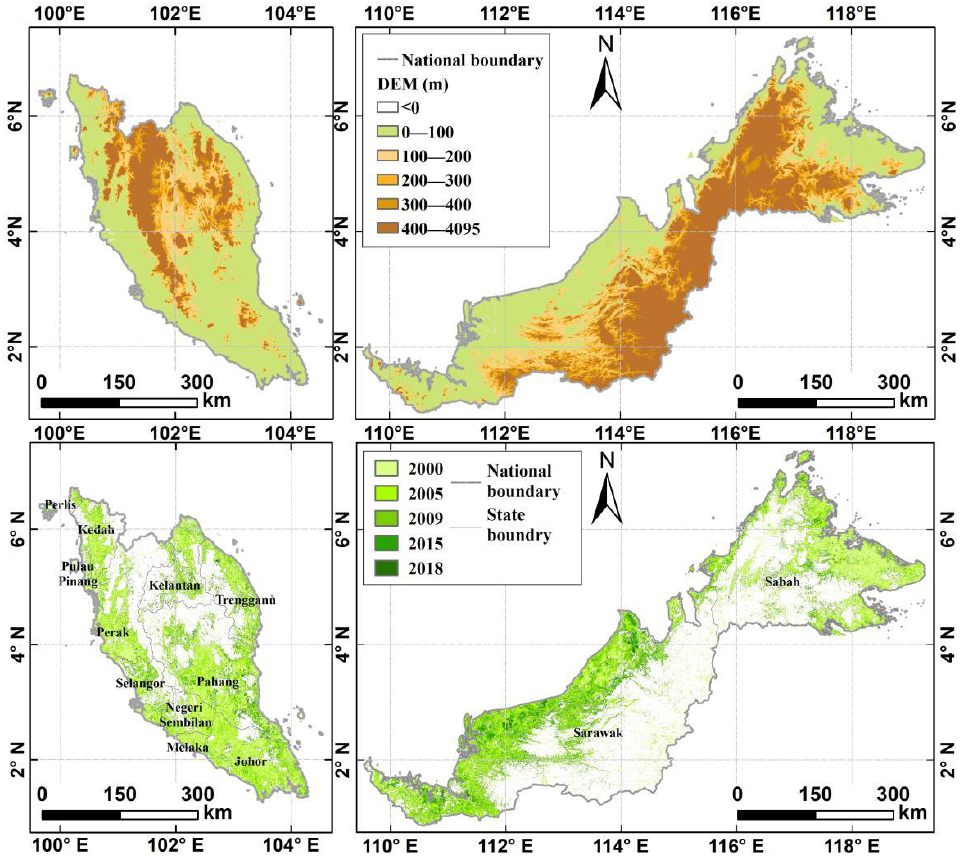
Figure 9. Spatial distribution of oil palms at different elevations. ( a ) DEM with different elevation zones and ( b ) spatial distribution of oil palms.